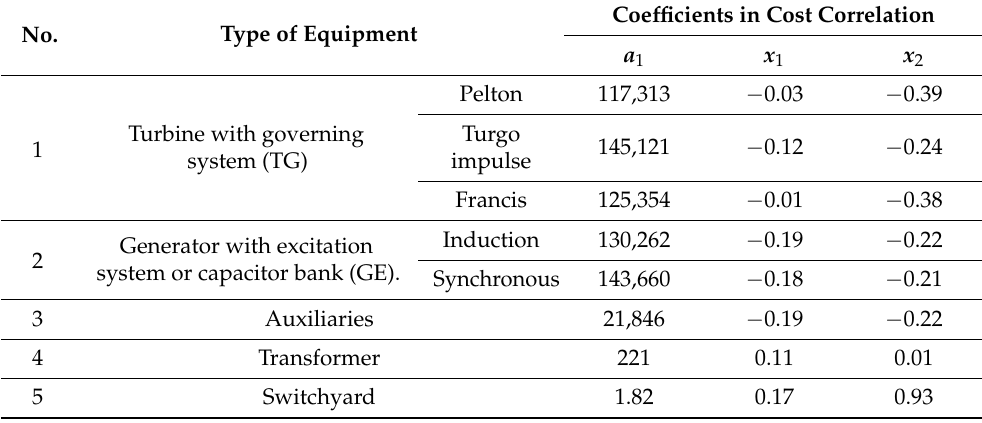
Table 8. Coefficients in cost correlation for electromechanical equipment with different types [51]. No. Type of